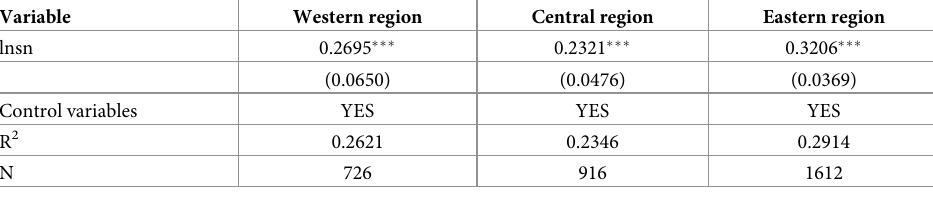
Table 9. Estimated results by